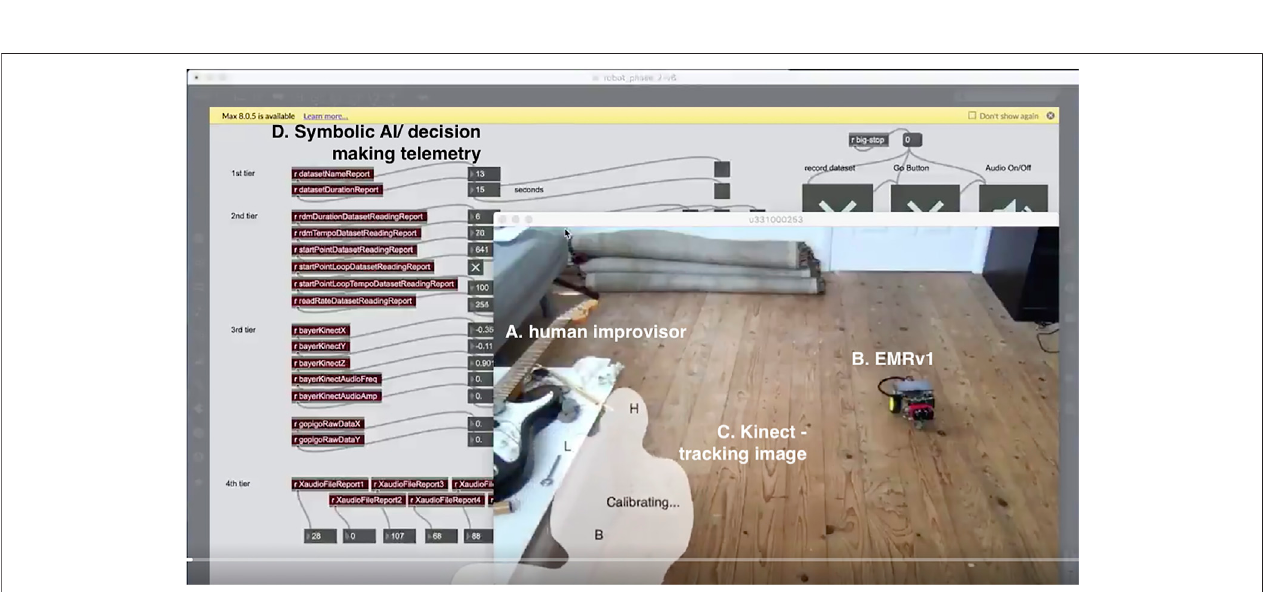
FIGURE 2 | Image of a performance/training session between the author improvising on table-top electric guitar (A) and EMRv1 (B) . The image collages the real- time tracking of the Kinect (the ghost image C.), and the data-logging page of Max/MSP patch (D) . A video of this session can be found online. 7